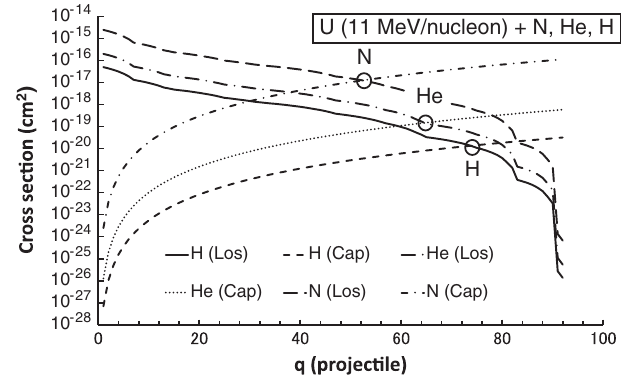
FIG. 3. Simple estimation of cross sections of e-loss and and (cid:2) C ) for uranium beam in the gases of e-capture ( (cid:2) L BEM SCH N , He, and H , calculated as a function of the charge state by 2 2 using the binary encounter model [25] and Schlachter’s formula [26]. The circles indicate the intersections of the two lines.